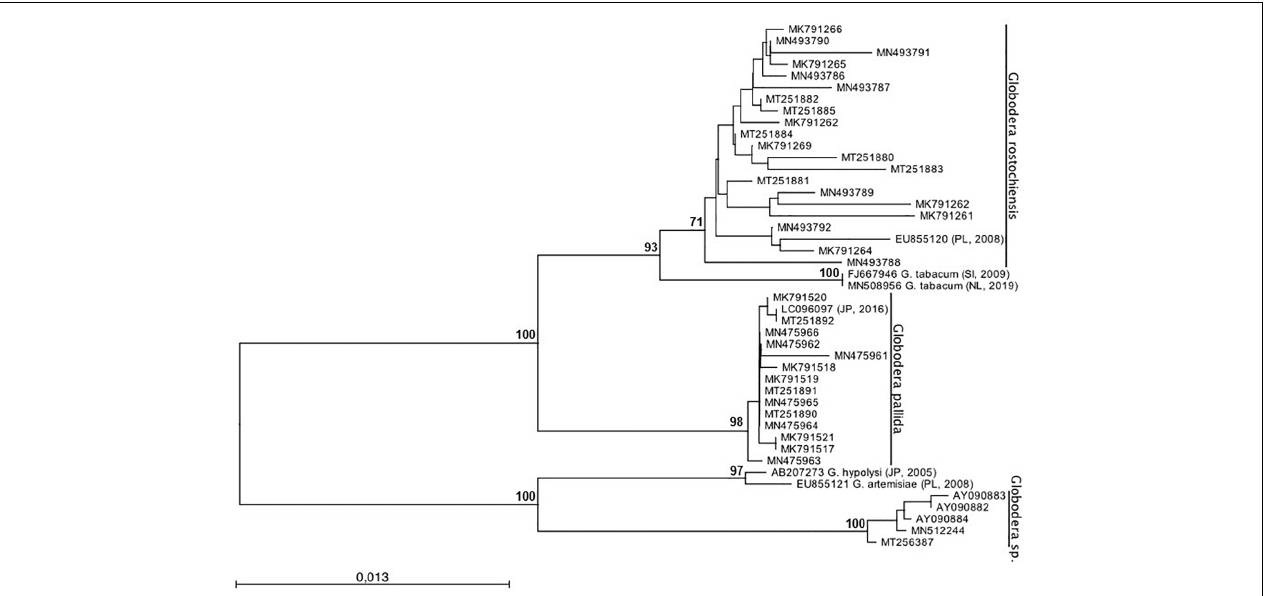
FIGURE 4 | Phylogenetic relationships of 36 Globodera sp. isolates collected from Portugal based on the sequence alignment of the ITS-rDNA loci. The condensed phylogenetic tree was generated using the Maximum Likelihood method based on the HKY + G model with 1,000 bootstrap replications. Bootstrap values are indicated at the nodes (bootstrap higher than 70%). The analysis involved a total of 45 nucleotide sequences. All positions containing gaps and missing data were eliminated. Globodera tabacum , G. hypolysi , and G. artemisiae were used as outgroup.